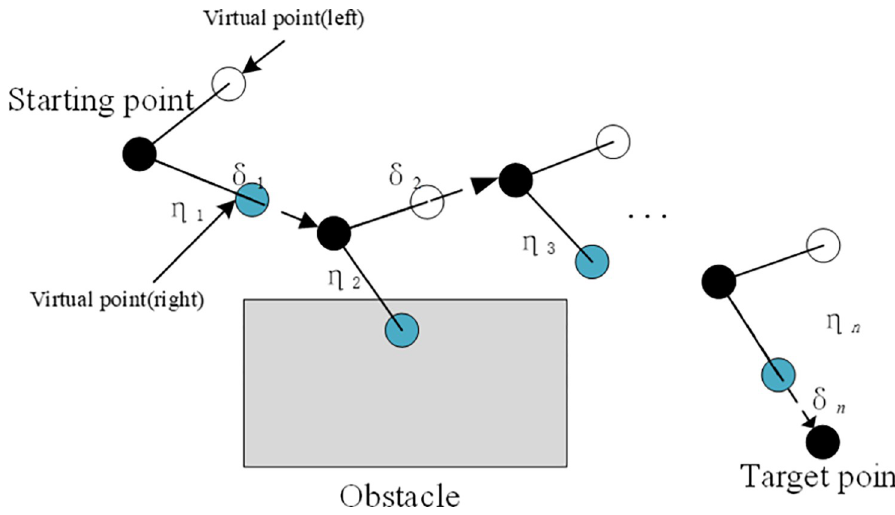
Fig 2. Pathfinding process of the